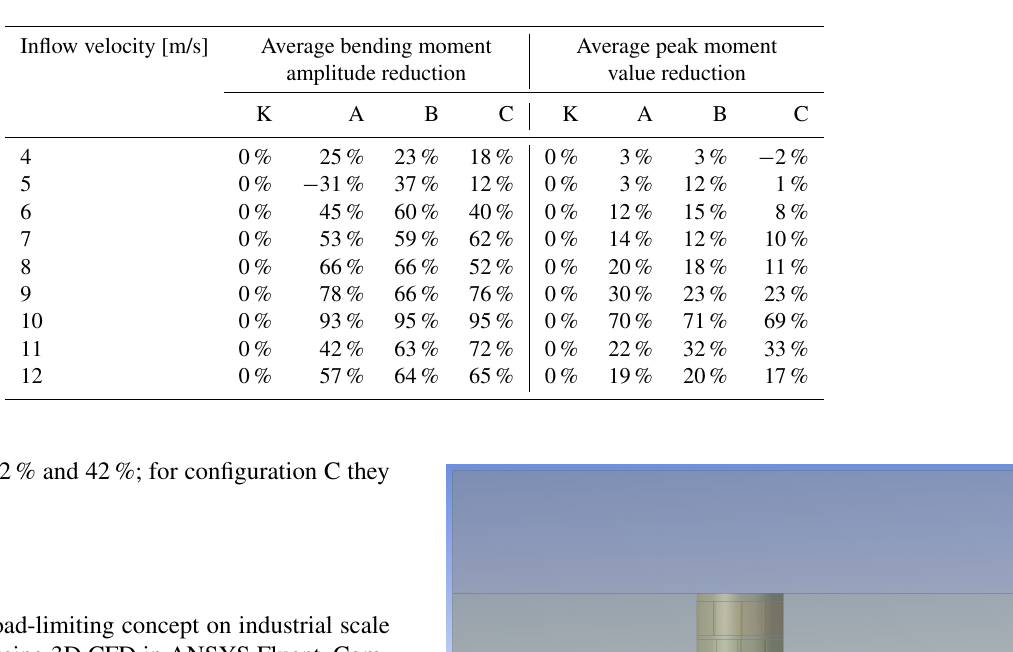
Table 5. Result comparison for different scenarios.